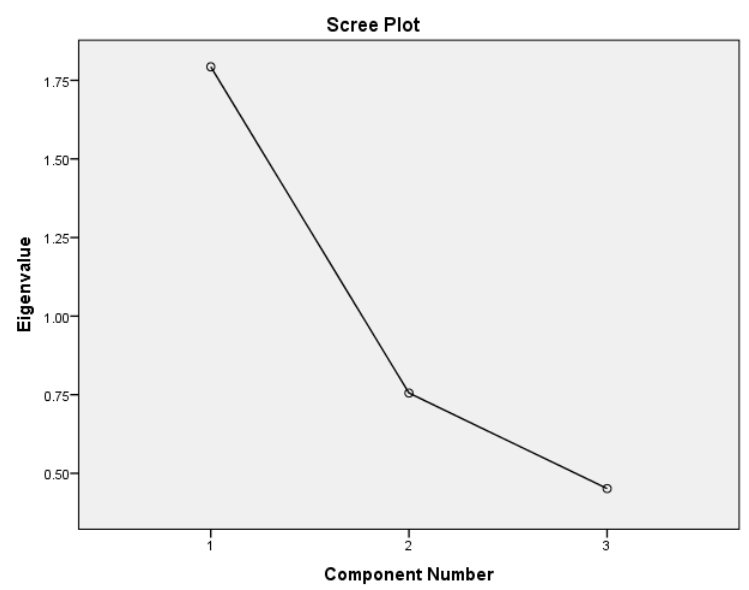
Figure 7. Sedimentation graph of the Teachers’ Digital Competence. Source: Authors.